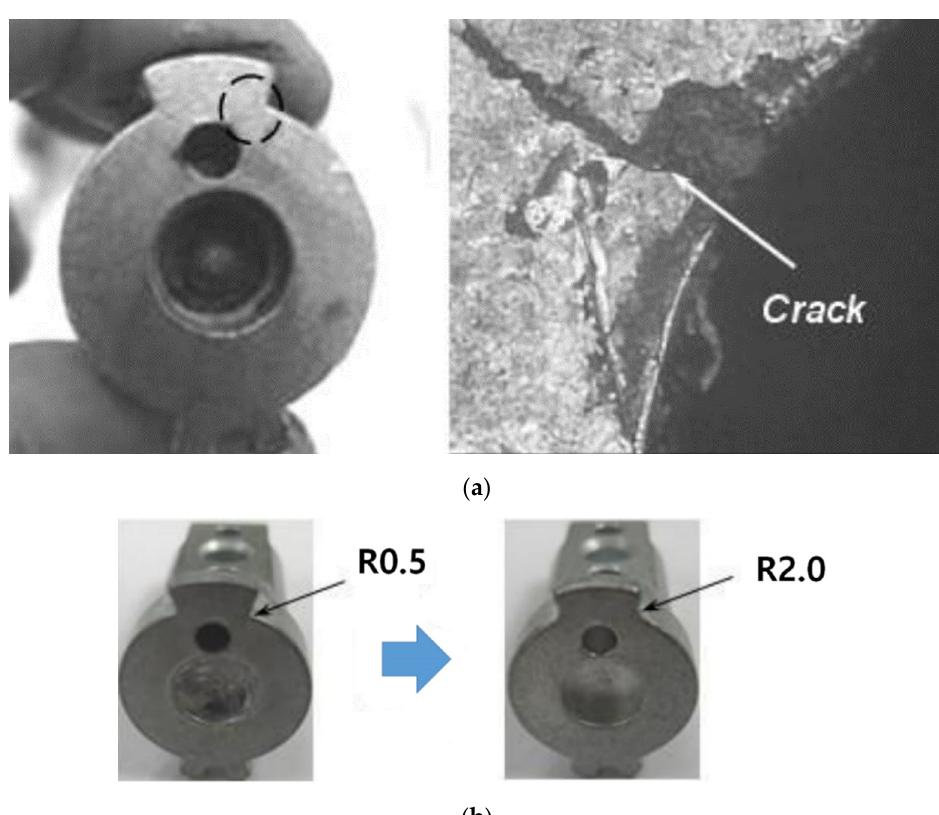
Figure 12. Root cause and design modification of cracked torsional shaft (cast iron) in the second ALT: ( a ) Root cause; ( b ) design modification.